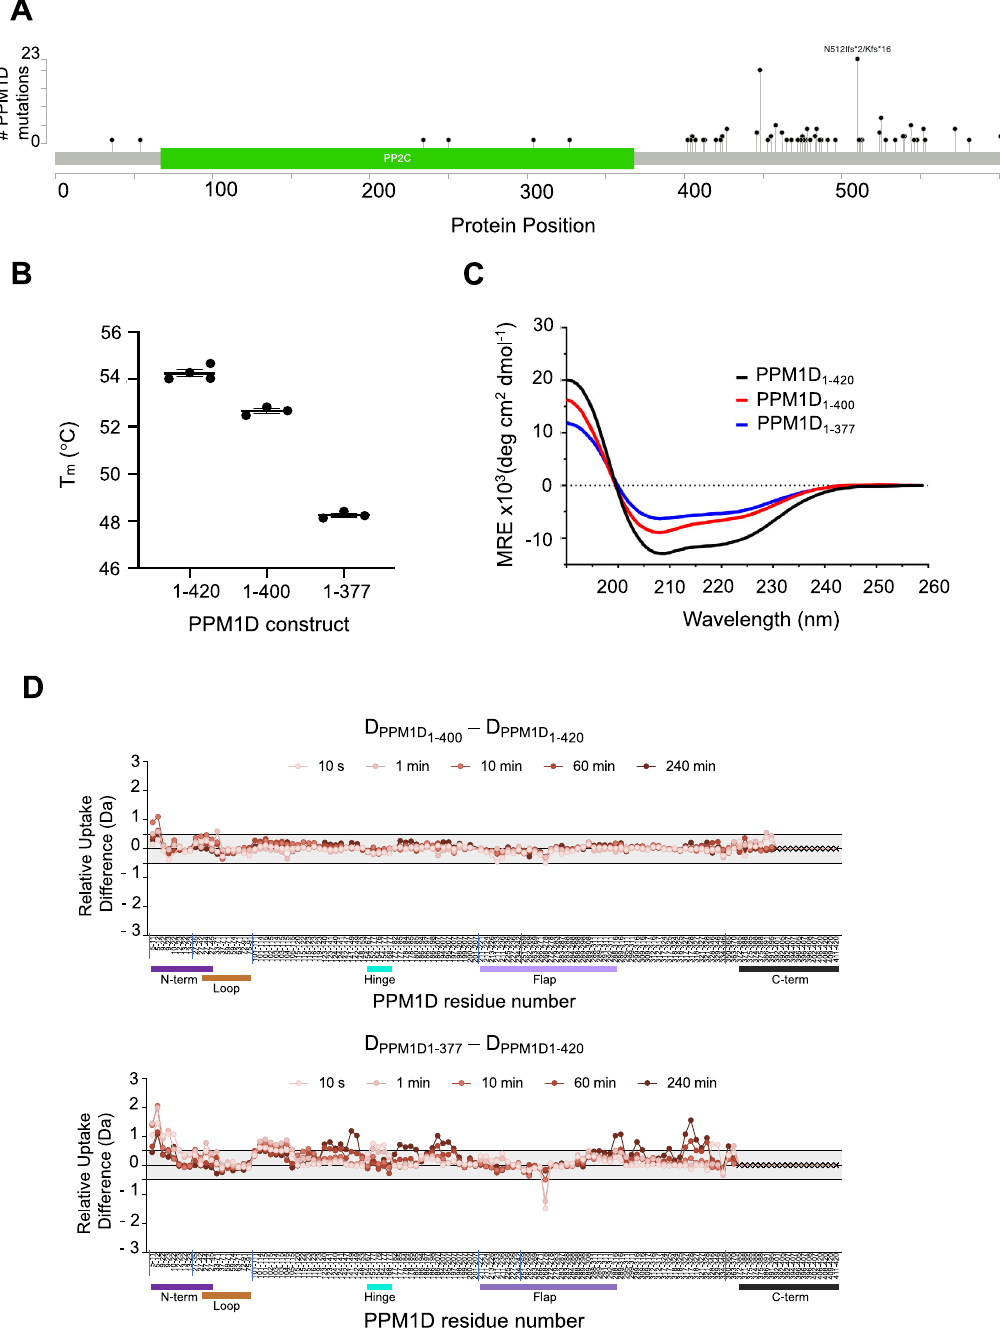
Fig. 7 Truncations proximal to amino acid 400 destabilize PPM1D. A Distribution of PPM1D truncating mutations in solid tumor sequencing data from GENIE (v5.0) obtained from cBioportal (www.cbioportal.org). B Effects of different truncations on the thermal stability of PPM1D by differential scanning calorimetry. N = 3 independent sample runs. Data are presented as mean values ± SD. Source data are provided as a Source Data fi le. C Circular dichroism analysis of PPM1D 1 – 420 (black), PPM1D 1 – 400 (pink) and PPM1D 1 – 377 (brown). D Relative differences in deuterium uptake between PPM1D 1 – 420 and PPM1D 1 – 400 (top) and between PPM1D 1 – 420 and PPM1D 1 – 377 (bottom) as assessed by HDX-MS. Vertical tick marks between peptides on the X -axis are shown to indicate regions of missing coverage. The bars below the X -axis represent the N-terminus (purple), loop (brown), hinge (cyan), fl ap (light purple), and C-terminus (black) of the